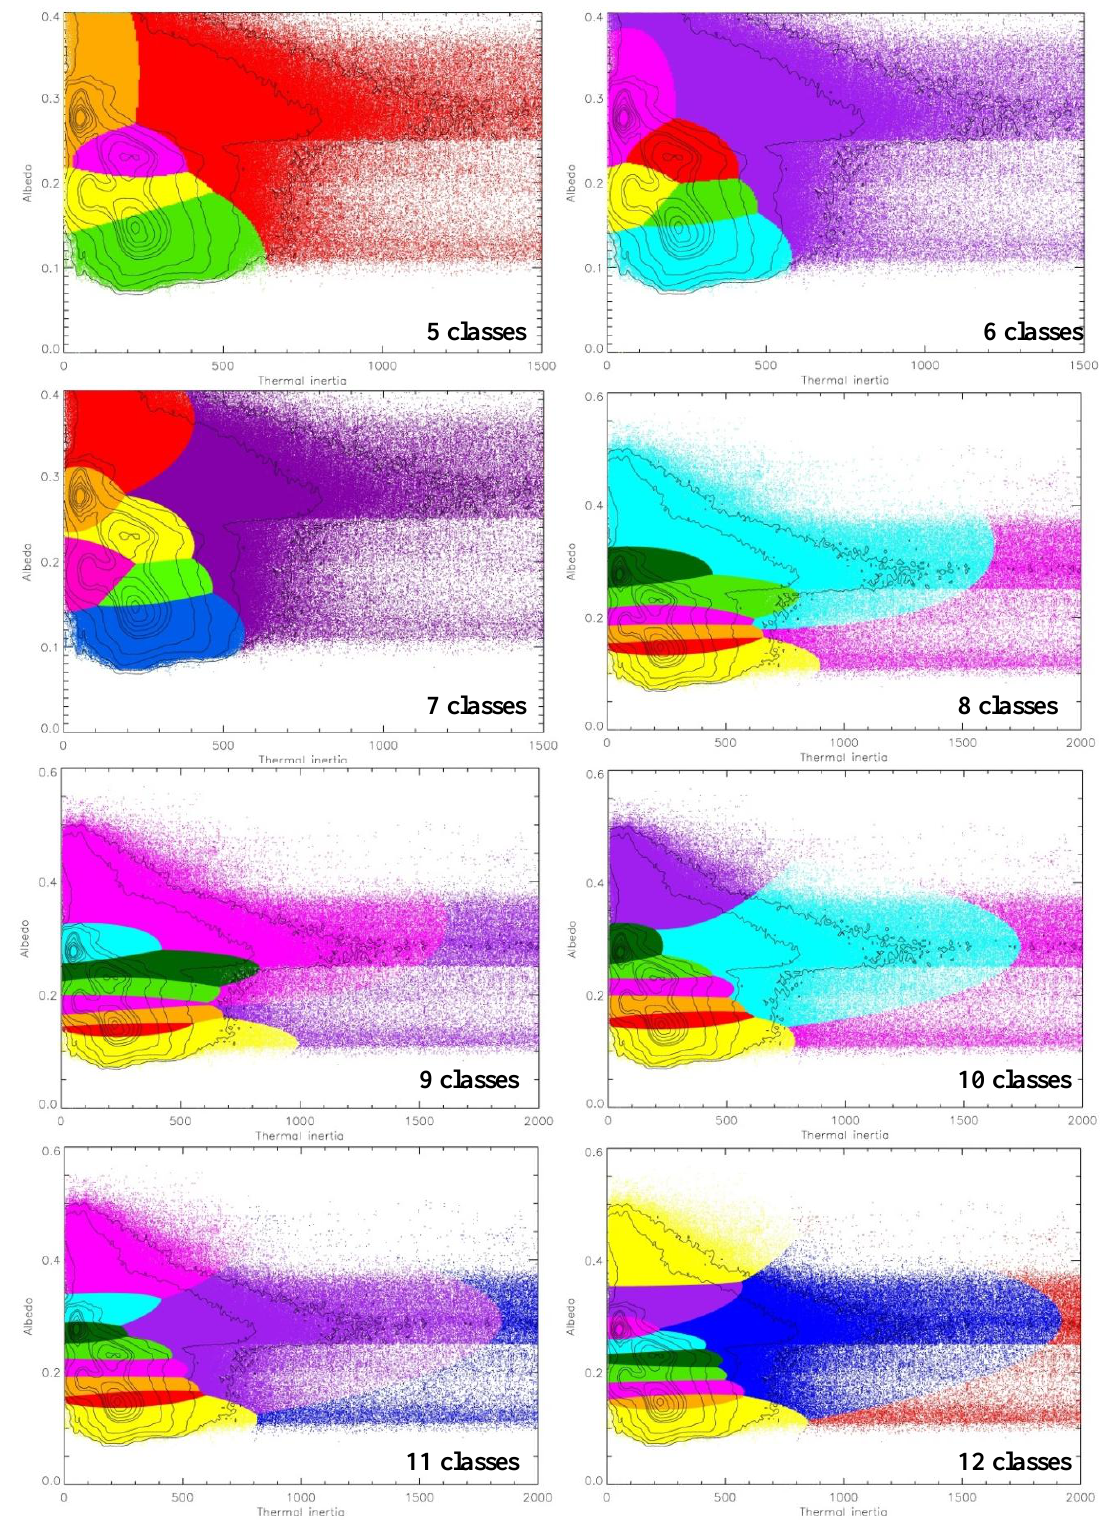
Figure 6. Assignment of pixels for varying values of N in the ISODATA and MAXLIKE classification. Horizontal axis has been truncated so not all classes may be visible in the